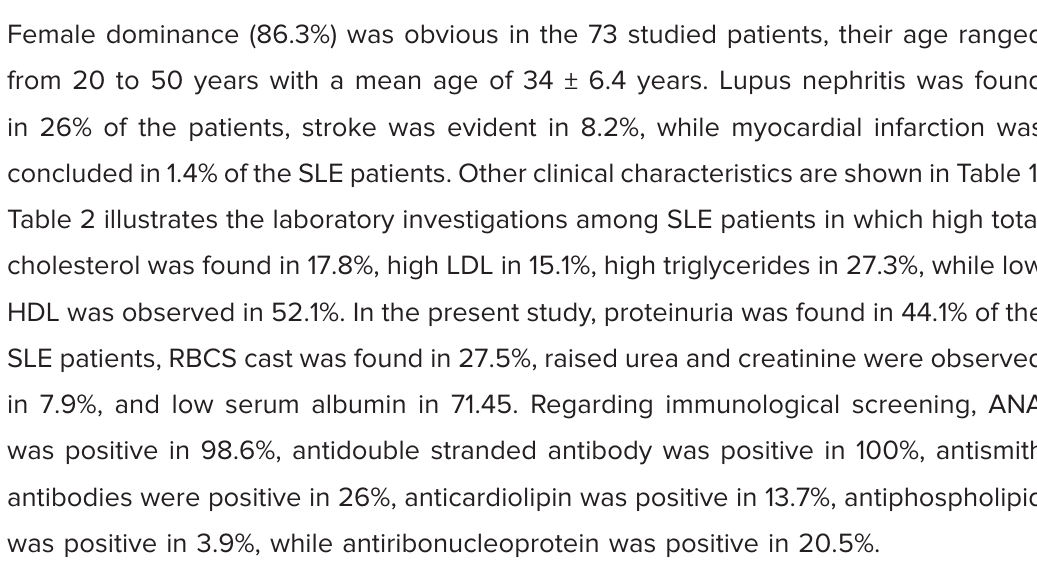
Table 1: Clinical Characteristics of Systemic Lupus Erythematosus Patients.